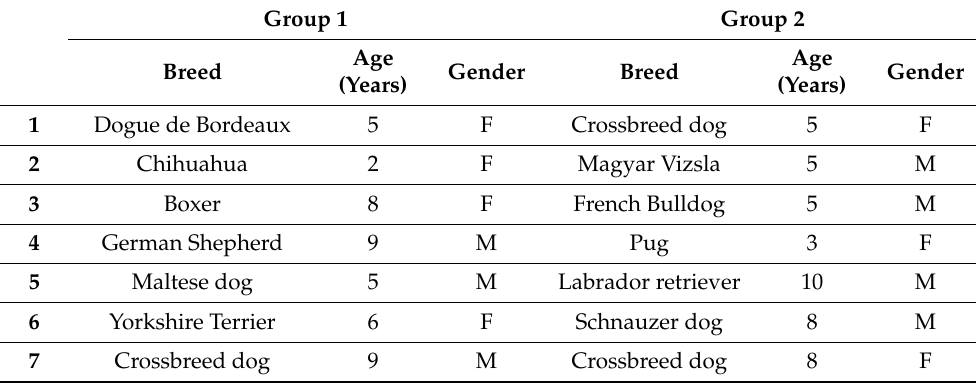
Table 1. The first and the second group of dogs included in the